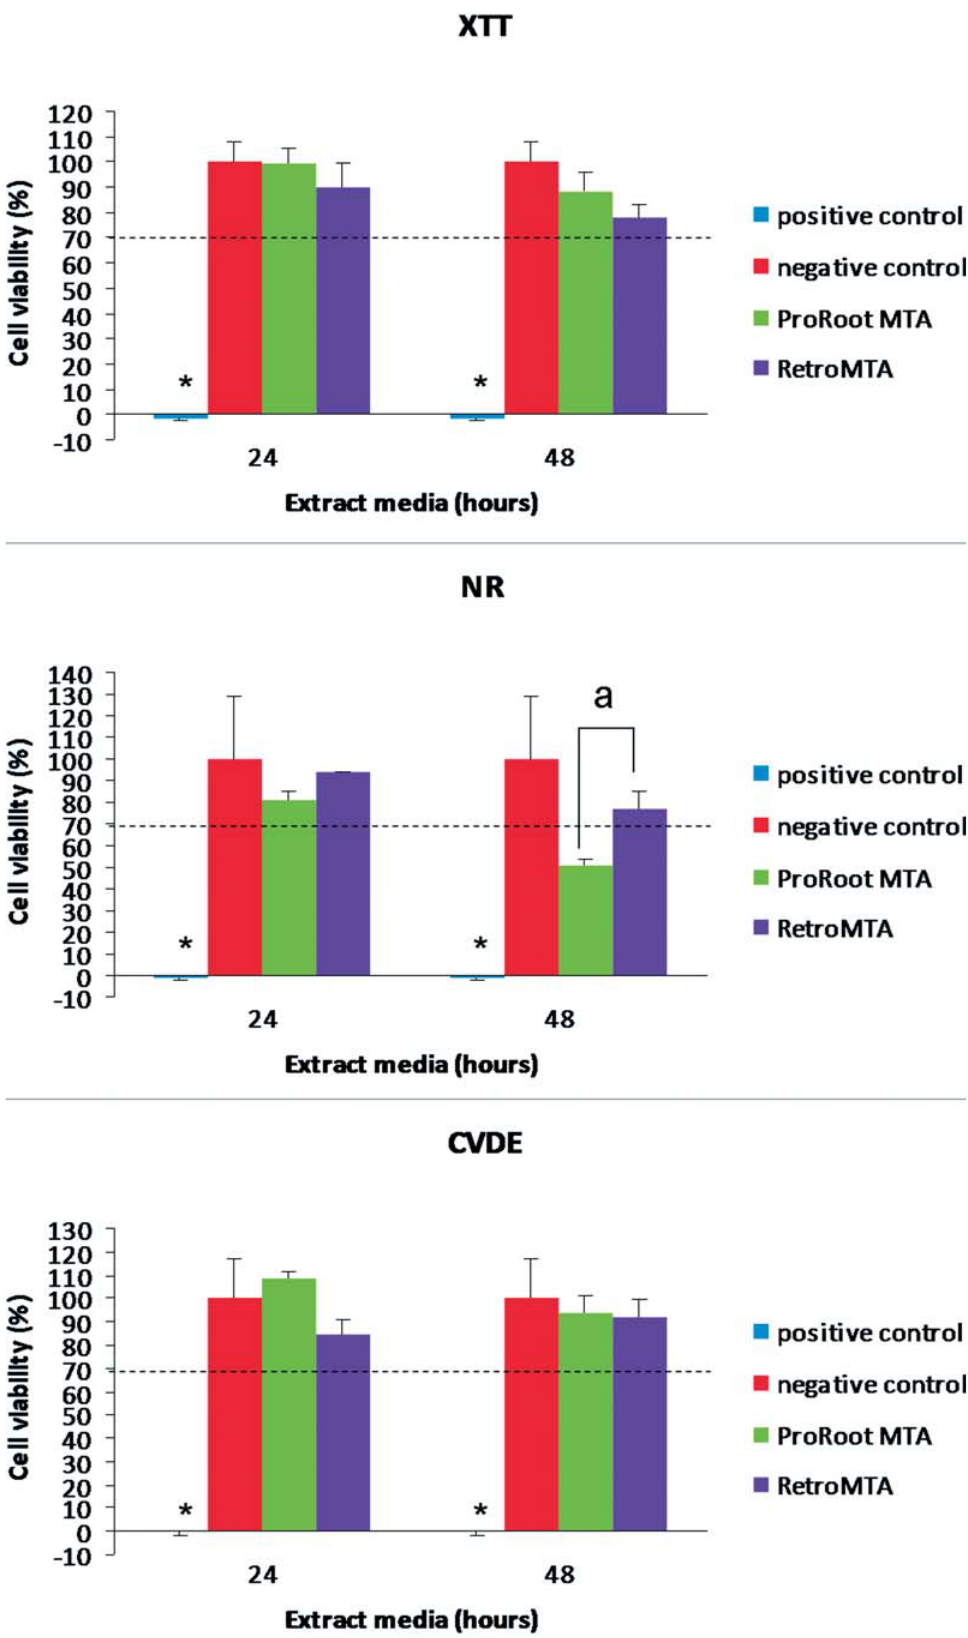
Figure 4- (cid:13)(cid:23)(cid:16)(cid:11)(cid:11)(cid:13)(cid:24)(cid:4)(cid:9)(cid:25)(cid:4)(cid:11)(cid:4)(cid:10)(cid:12)(cid:13)(cid:26)(cid:27)(cid:28)(cid:13)(cid:9)(cid:15)(cid:10)(cid:16)(cid:17)(cid:13)(cid:16)(cid:29)(cid:18)(cid:30)(cid:31)!(cid:17)(cid:16)(cid:13)(cid:10)(cid:30)(cid:13)(cid:16)(cid:9)(cid:8)"(cid:13)#(cid:9)(cid:10)(cid:16)(cid:17)(cid:4)(cid:9)(cid:11)(cid:13)(cid:16)(cid:29)(cid:10)(cid:17)(cid:9)(cid:8)(cid:10)(cid:13)#(cid:16)(cid:14)(cid:4)(cid:9)(cid:21)(cid:13)(cid:2)(cid:3)(cid:4)(cid:5)(cid:6)(cid:4)(cid:7)(cid:8)(cid:9)(cid:6)(cid:10)(cid:11)(cid:12)(cid:13)(cid:14)(cid:4)(cid:15)(cid:15)(cid:16)(cid:17)(cid:16)(cid:6)(cid:10)(cid:13)(cid:15)(cid:17)(cid:30)#(cid:13)(cid:9)(cid:11)(cid:11)(cid:13)(cid:5)(cid:17)(cid:30)!(cid:18)(cid:31)(cid:13)(cid:26)(cid:18)(cid:19)(cid:20)(cid:21)(cid:20)(cid:20)(cid:20)(cid:22)(cid:28)(cid:21)(cid:13)